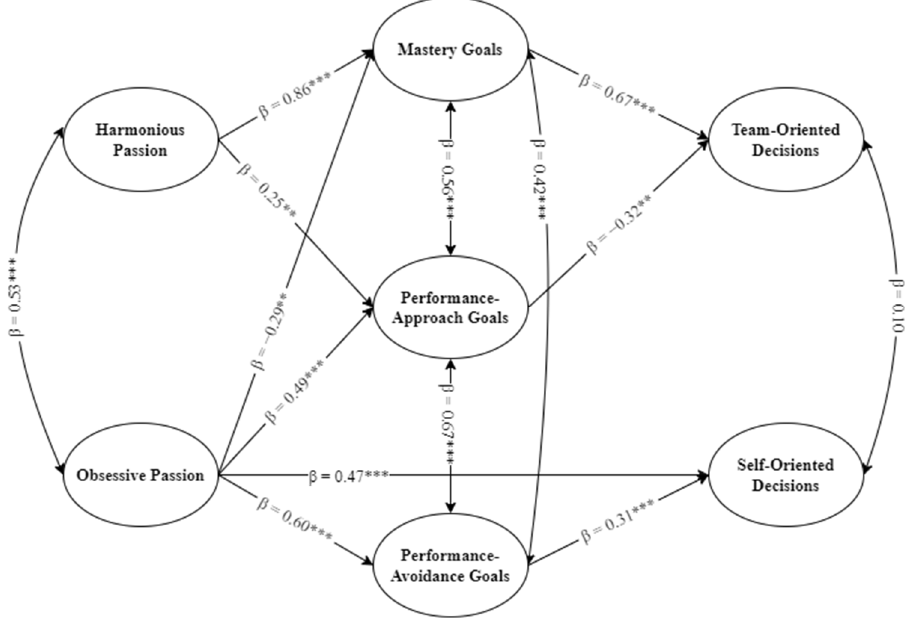
Figure 1. Structural Equation Model-Relations Between Passion, Achievement Goals, and Decisions. N = 253. β = standardized beta. ** p < 0.01; *** p < 0.001.